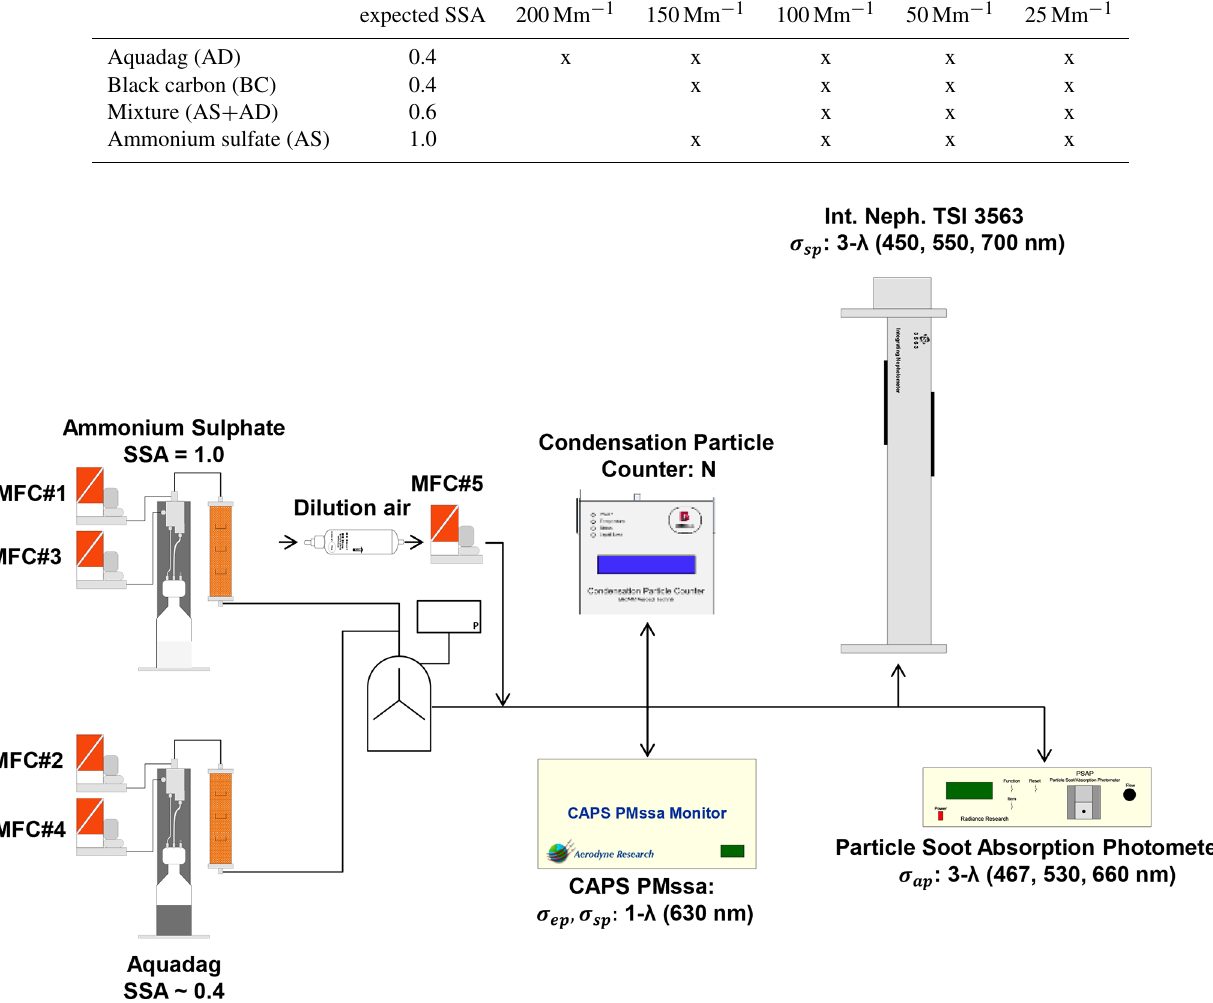
sioned such that the flow velocities in the sample tube and inside extraction tip nozzles match. Distances between the extraction points for the different instruments were 20